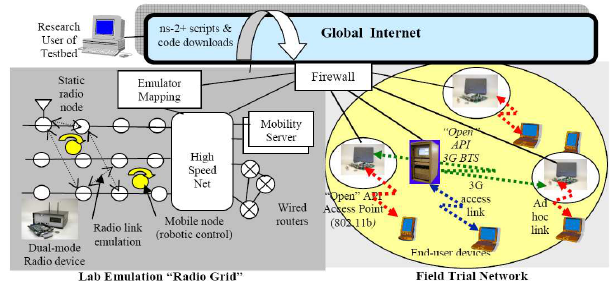
Figure 13. High-level view of proposed 2-tier system architecture for